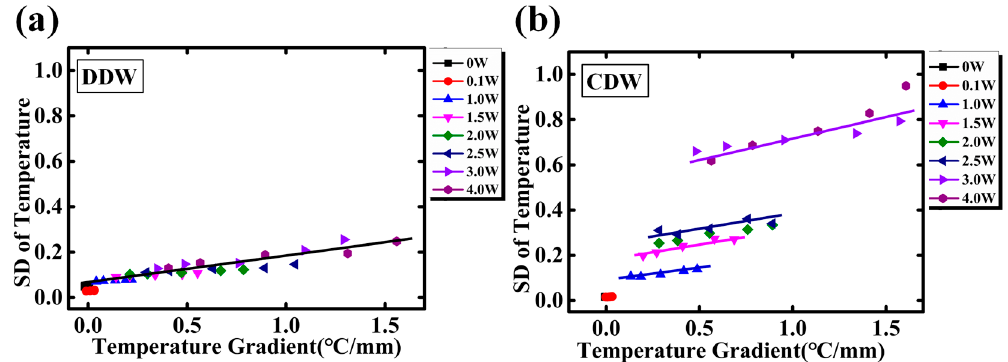
Figure 11. ( a ) DDW is used as coolant, the temperature fluctuation changes with temperature gradient at different input power and ( b ) CDW is used as coolant, the temperature fluctuation changes with temperature gradient at different input power.